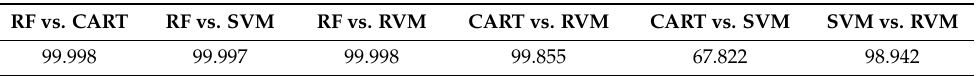
Table 7. Z-test results for classifier performance comparison at 95% confidence showing two-tailed probability with test sample size of 675 pixels on dataset D-2.